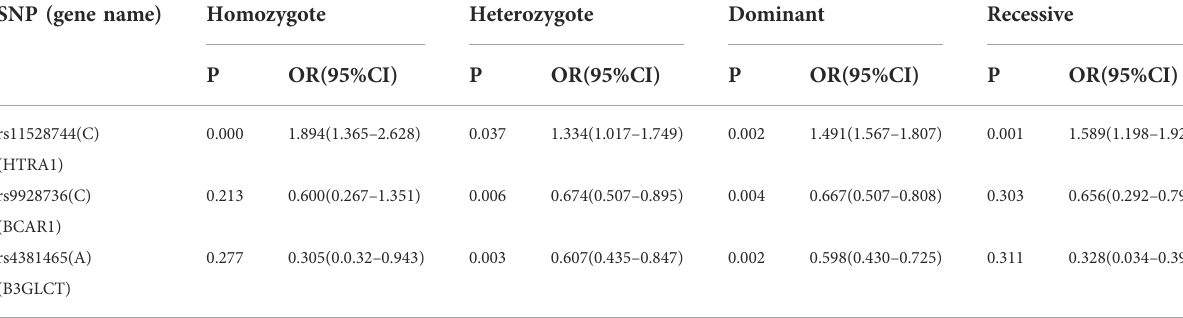
TABLE 4 Association analysis between three SNPs and AMD in four genetic